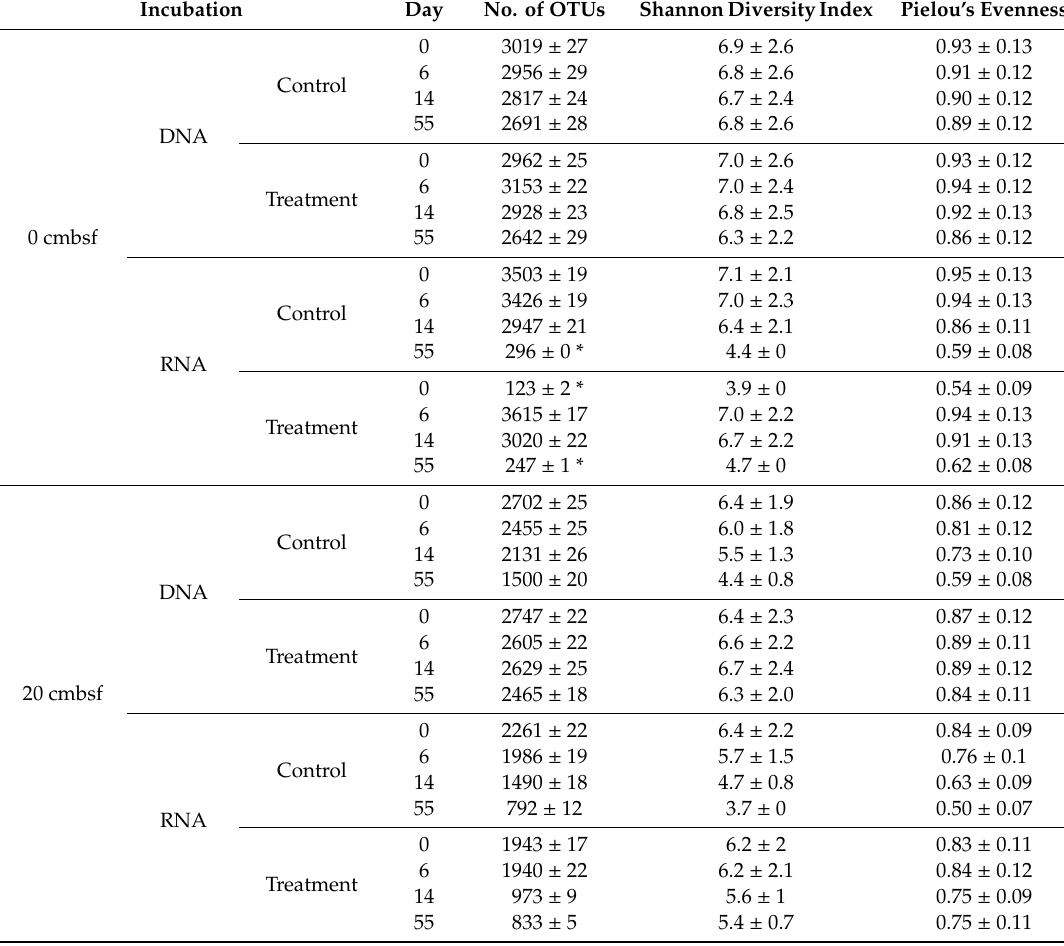
Table 1. Changes in the diversity indices for the bacterial communities of the 0 and 20 cmbsf slurry incubations, calculated from the libraries of 16S rRNA genes (DNA) and transcripts (RNA) over the experimental